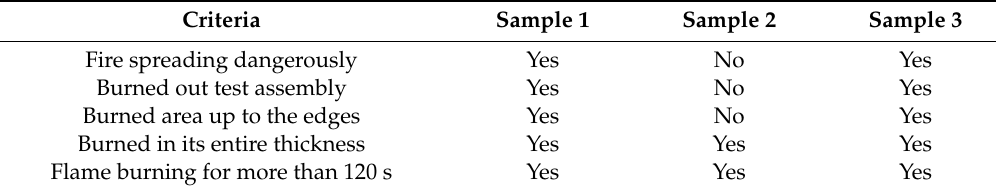
Table 4. Evaluation tests using an equivalent of a match flame according to the given criteria [9]. Criteria Sample 1 Sample 2 Sample 3 Fire spreading dangerously Yes No